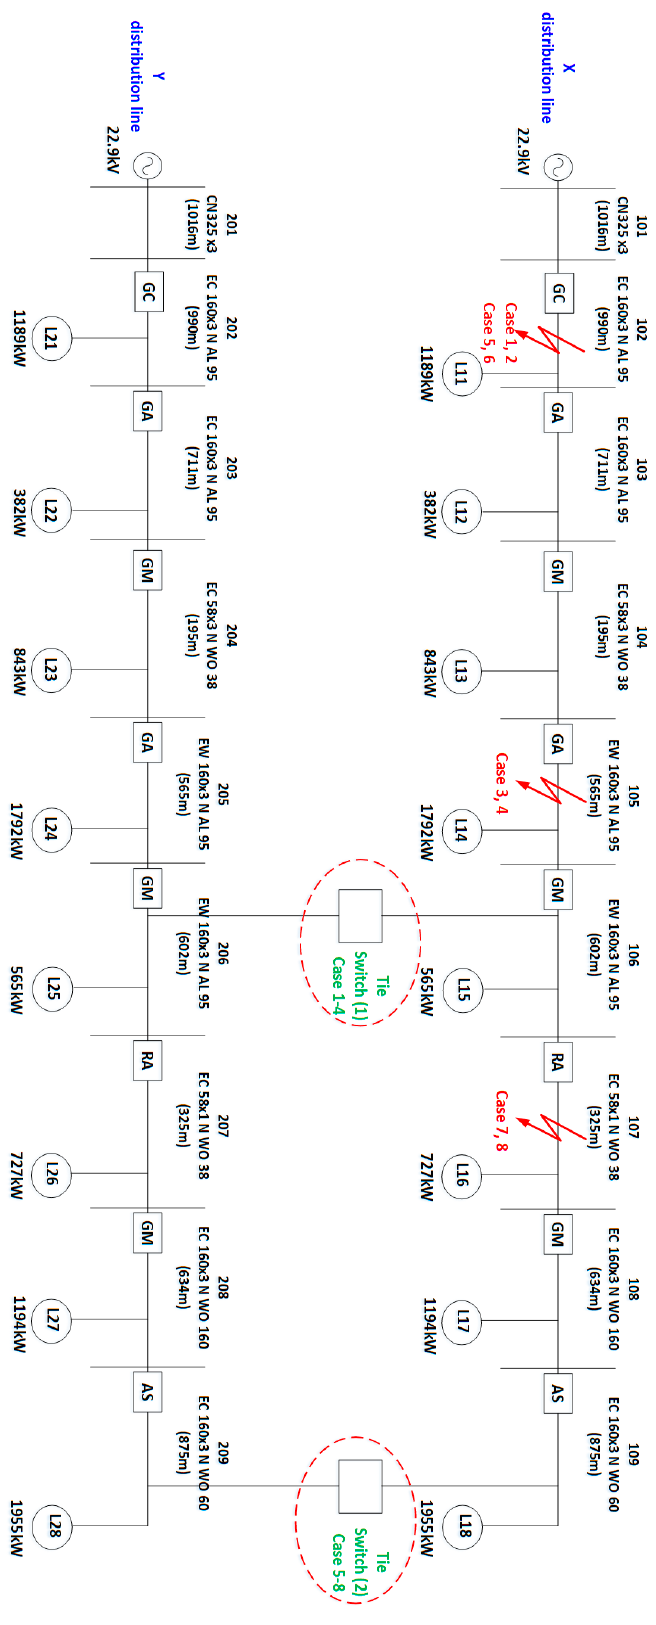
Figure 16. Actual Korea Electric Power Corporation distribution system model.